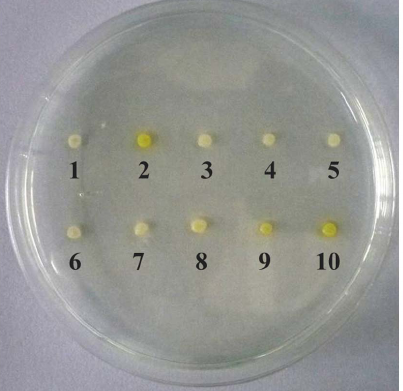
Figure 5. P.pastoris display of Bm AChE on an MM-B plate: 1, GS115; 2, GS115/pPIC9K- bmace-AG a 1 ; 3–10, GS115/pPIC9K- bmace-AG a 1 inhibited by different concentrations of eserine (clone 3: 10 2 2 M, clone 4: 10 2 3 M, clone 5: 10 2 4 M, clone 6: 10 2 5 M, clone 7: 10 2 6 M, clone 8: 10 2 7 M, clone 9: 10 2 8 M, clone 10: 10 2 9 M).